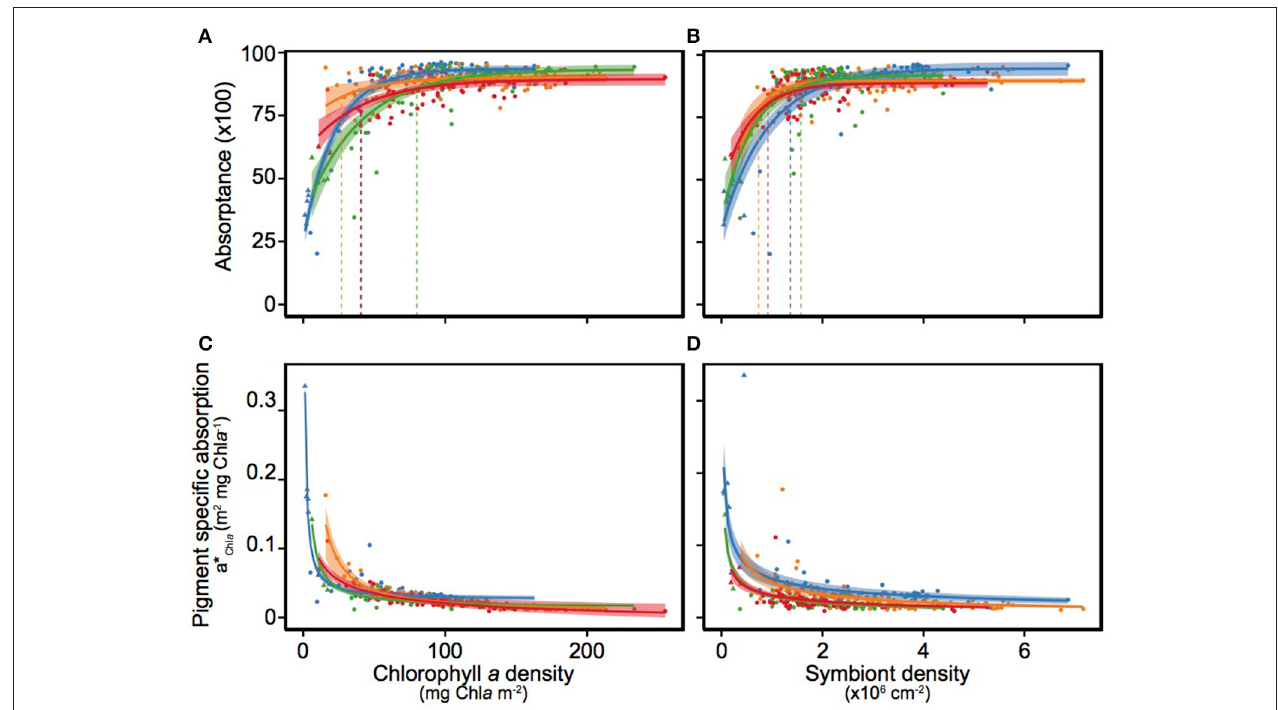
FIGURE 6 | Description of the variation of absorptance (A) and pigment specific absorption (a * Chl a ) as a function of changes in chlorophyll a (A,C) and symbiont density (B,D) , for Orbicella annularis (blue), Orbicella faveolata (orange), Montastraea cavernosa (green), and Pseudodiploria strigosa (red). Solid lines mark the asymptotic fits for each coral species and the shade area represents the extension of the 95 and 5% confident intervals. Discontinuous vertical color lines mark the values of chorophyll a or symbiont density where A max was achieved for each